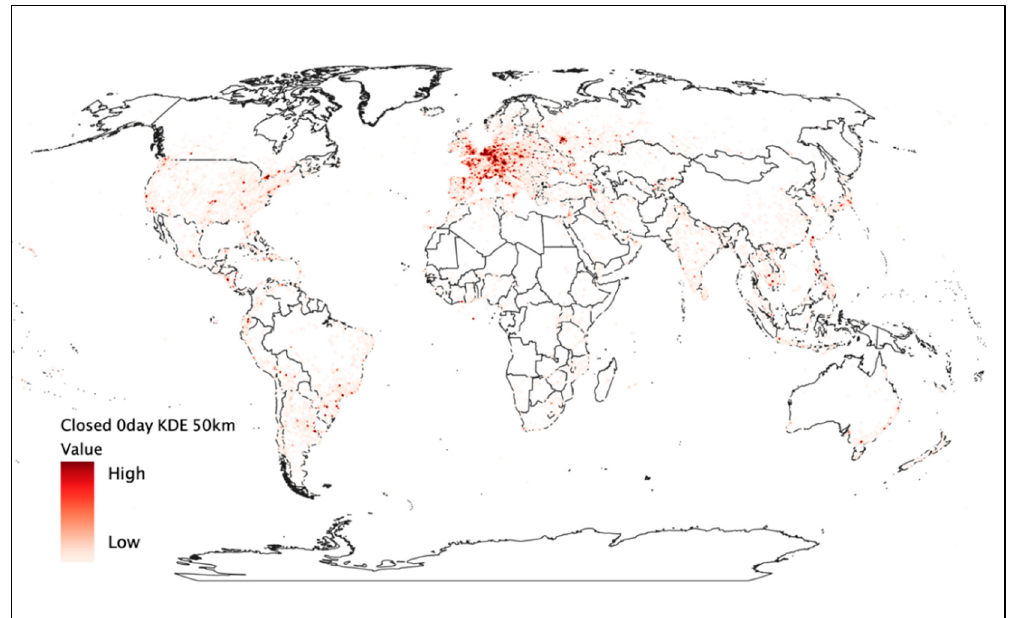
Figure 2. Distribution of closed OSM Notes resolved in 0 day using KDE.